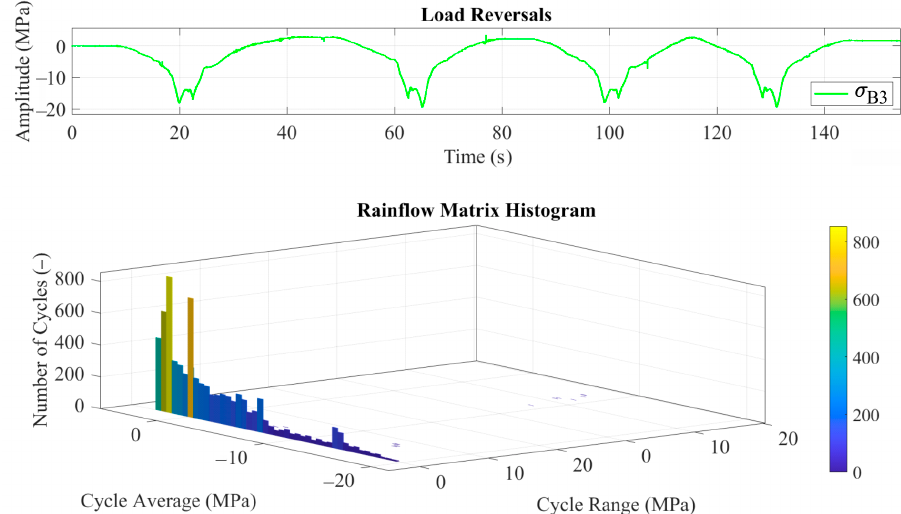
Figure 9. Spectrum of stress amplitudes, Mode 1.